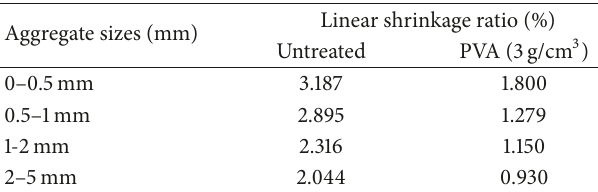
Table 3: The linear shrinkage ratio of specimens with different aggregate sizes.